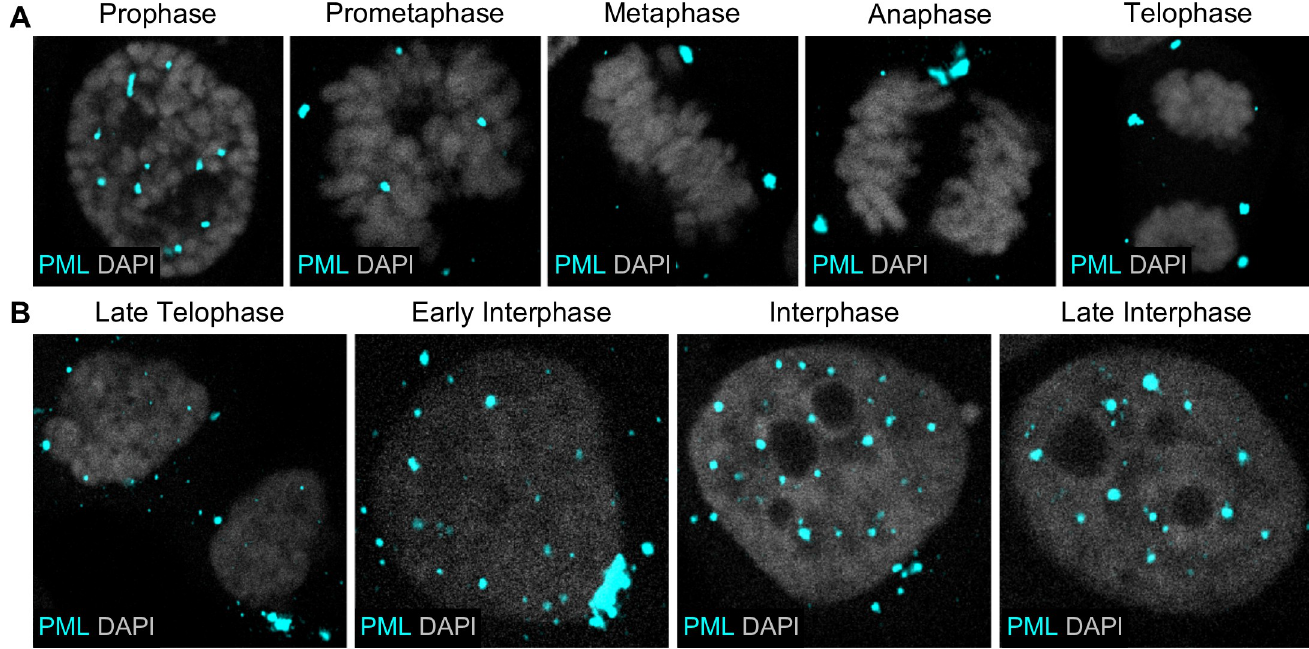
Fig 1. PML protein dynamics is used to approximate time during and after mitosis. HaCaT cells were grown on glass coverslips, then fixed, permeabilized, incubated with rabbit anti-PML protein antibody (cyan), and mounted with DAPI (white). Confocal images show cells in all stages of mitosis (A) and end of mitosis and stages of interphase